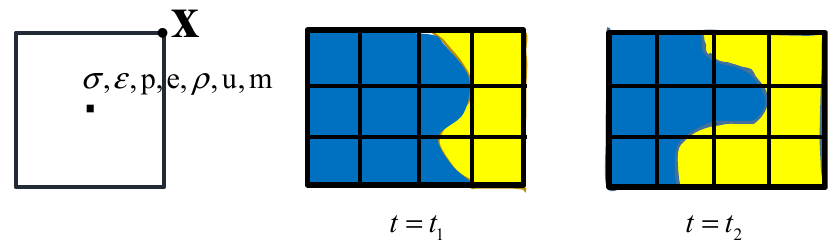
Figure 1. Materials transported in Euler.